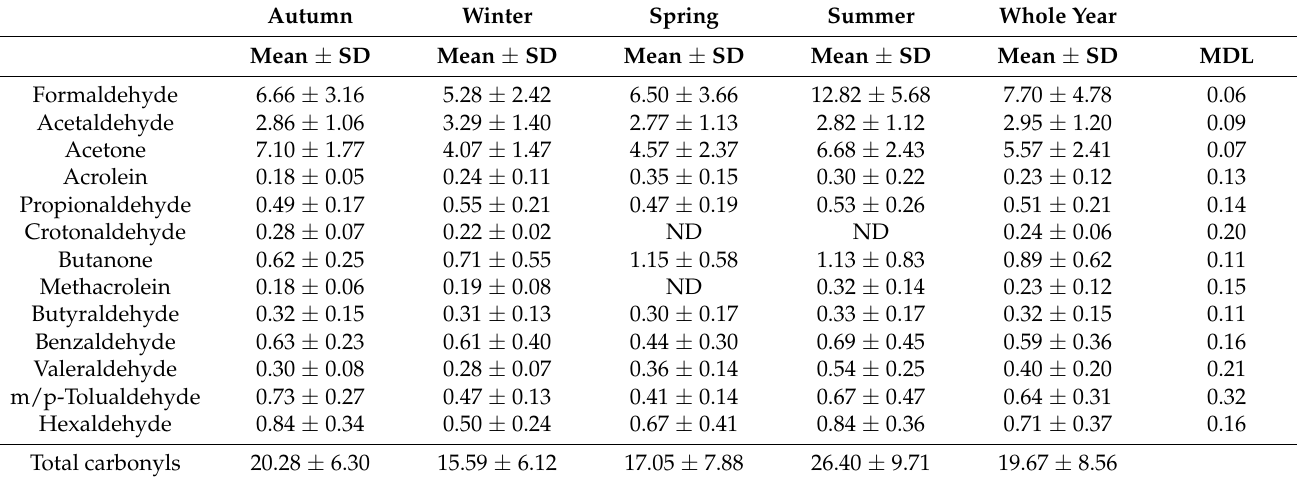
Table A1. Average concentrations of carbonyls in each season in Taiyuan ( µ g/m 3 ).